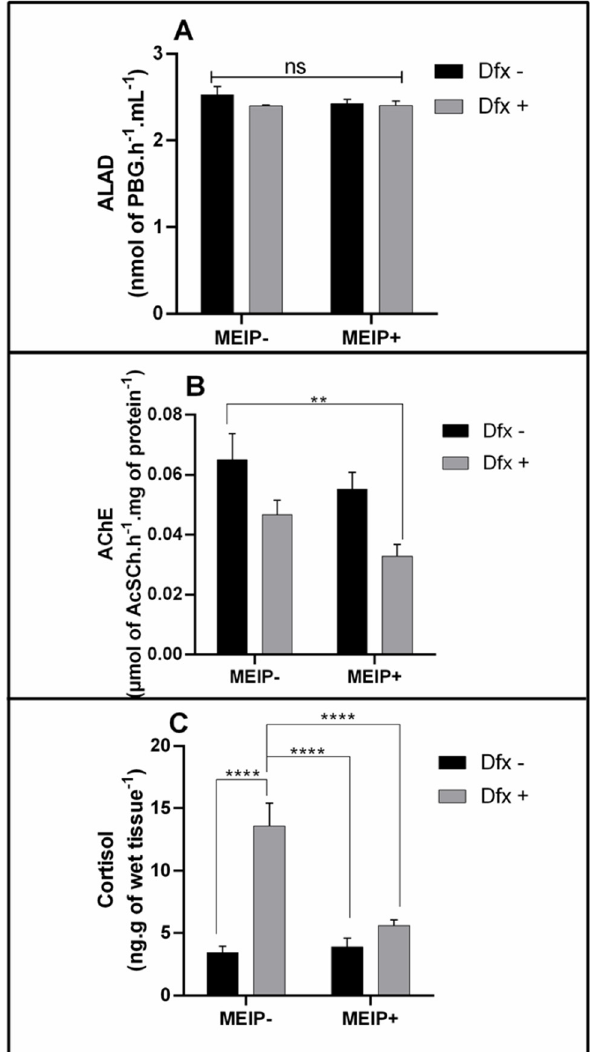
Figure 4. Delta-aminolevulinic acid dehydratase activity (ALAD) on Zebrafish brain ( A ); Acetylcholinesterase activity (AChE) on Zebrafish brain ( B ); and cortisol levels on Zebrafish whole body ( C ) exposed to Dfx-supplemented MEIP. Data are expressed by the mean ± SEM analyzed by ANOVA two-way with Tukey’s post-hoc test. ** p < 0.1 and **** p < 0.001, and ns = no significant .